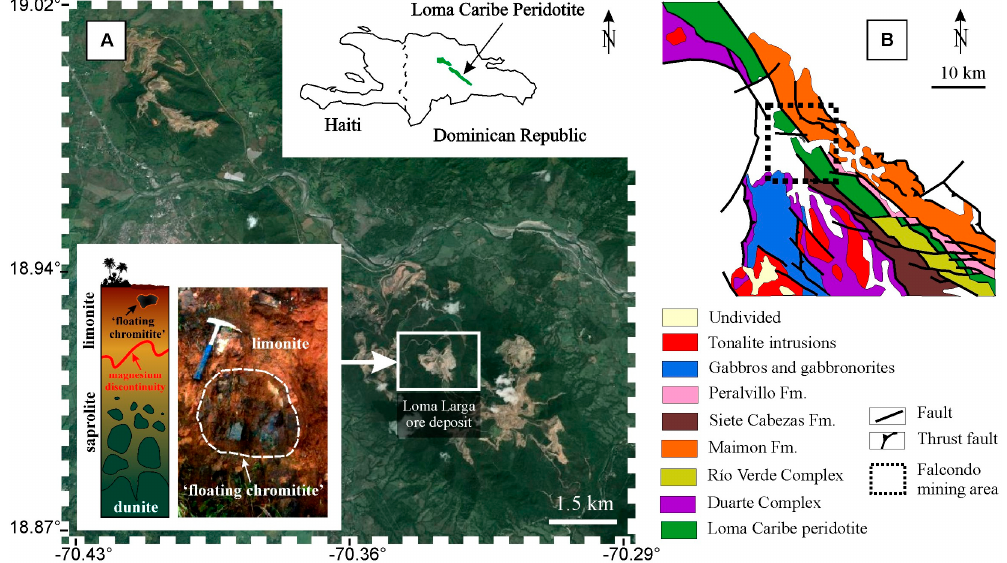
Figure 1. ( A ) The location of the Loma Caribe peridotite and an orthophotograph of the Falcondo mining area highlighting the Loma Larga ore deposit. The inset shows an idealized Ni-laterite soil profile from the Falcondo mining area as well as a field observation of the PGE-rich “floating chromitite” within limonite (width of image: ~1 m); ( B ) Simplified geological map of the central section of the Loma Caribe peridotite (modified from [17,18]).